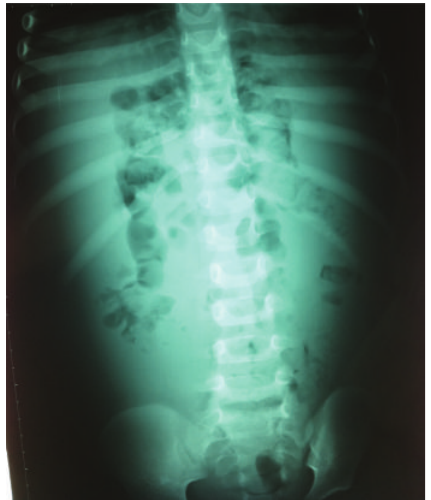
Figure 1: Medial displacement of the colic frame.